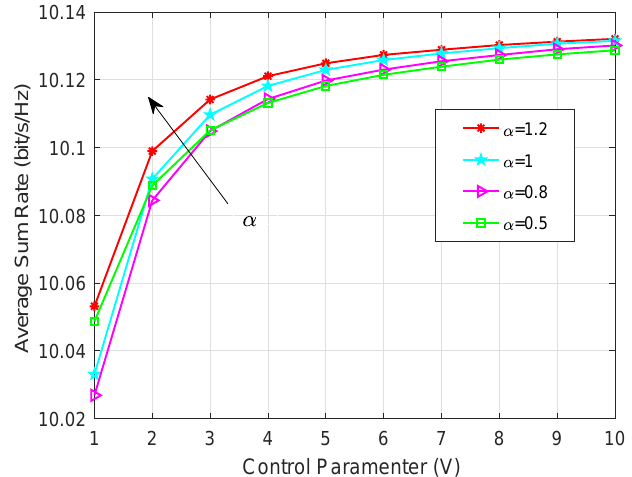
Figure 4. Time-averaged sum rate under different skewness parameter for K = 6, R T = 16 and P T = 0.2